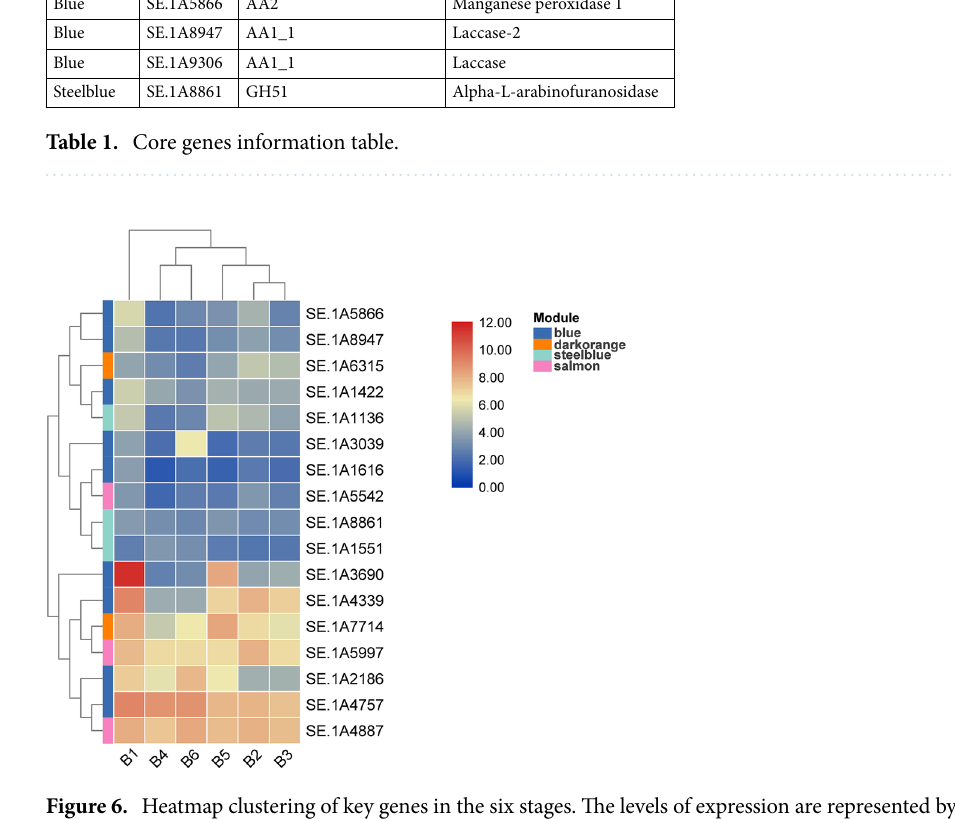
Figure 6. Heatmap clustering of key genes in the six stages. The levels of expression are represented by log2 (FPKM) values after centralization correction. Genes with similar patterns of expression are clustered together.